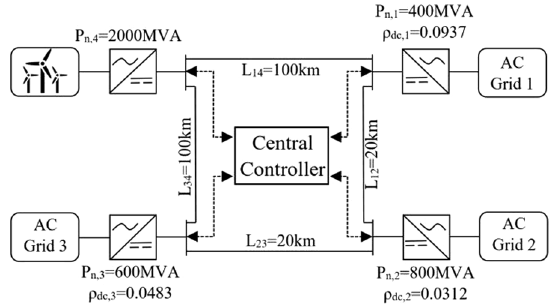
Fig. 3 Bipolar 4-terminal VSC-MTDC test system